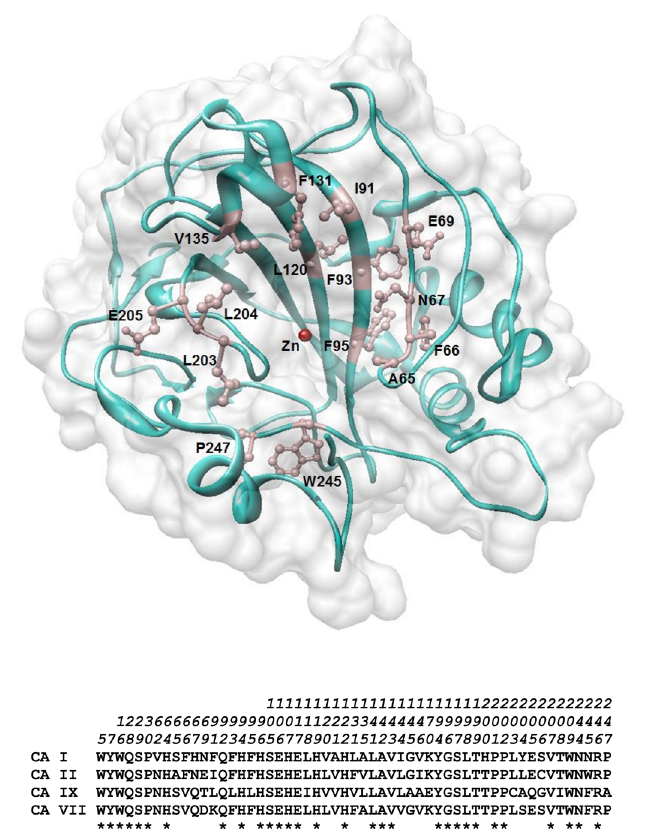
FIGURE 3 - Structure and Sequence alignment of hCA. Upper panel represents the structure of hCA II (PDB ID: 2VVB). Major cavity non-conserved residues are indicated in illustration. Lower panel shows the sequence alignment of hCA isoforms. Conserved positions are marked by asterisks. All the numberings are based on the sequence numbers of hCA